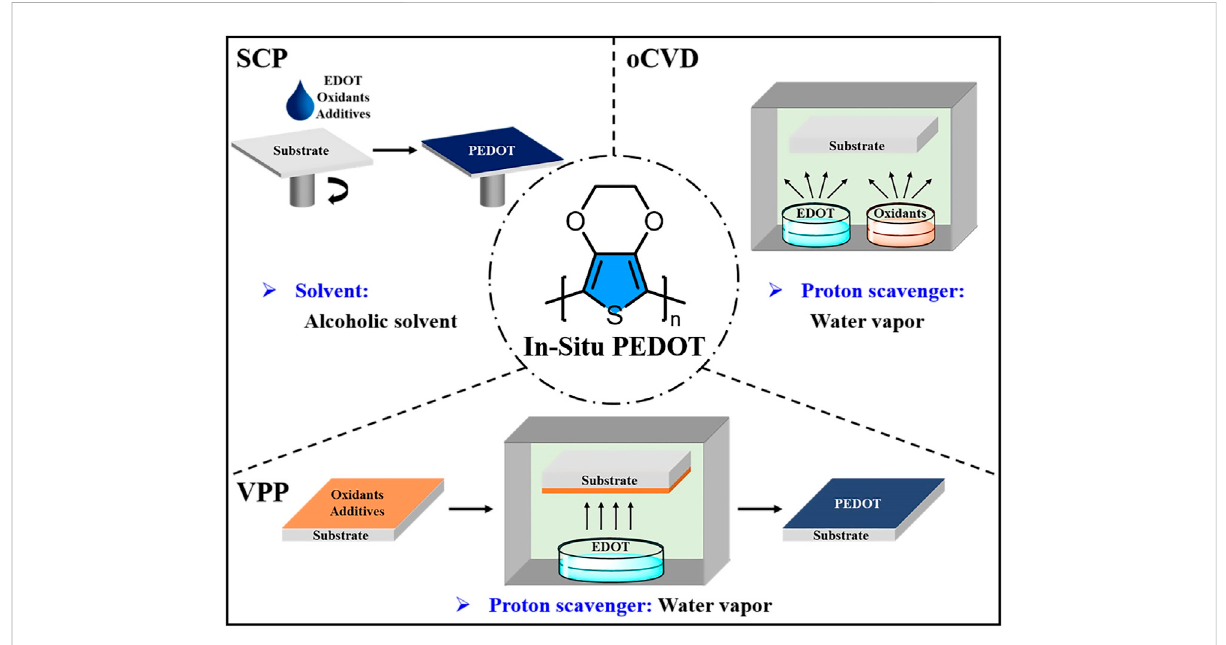
FIGURE 1 Utilization of green solvents to modify the in-situ PEDOT thin fi lms prepared by SCP, VPP and oCVD.